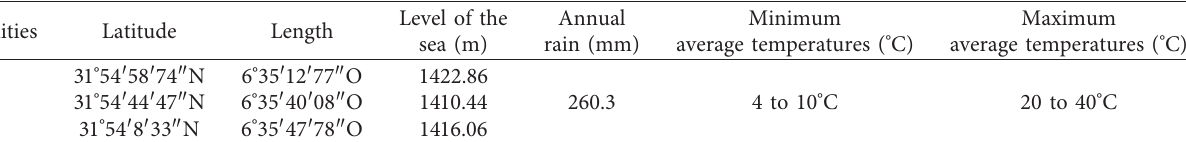
Table 1: Geographical parameters of the three localities of lentisk seeds.